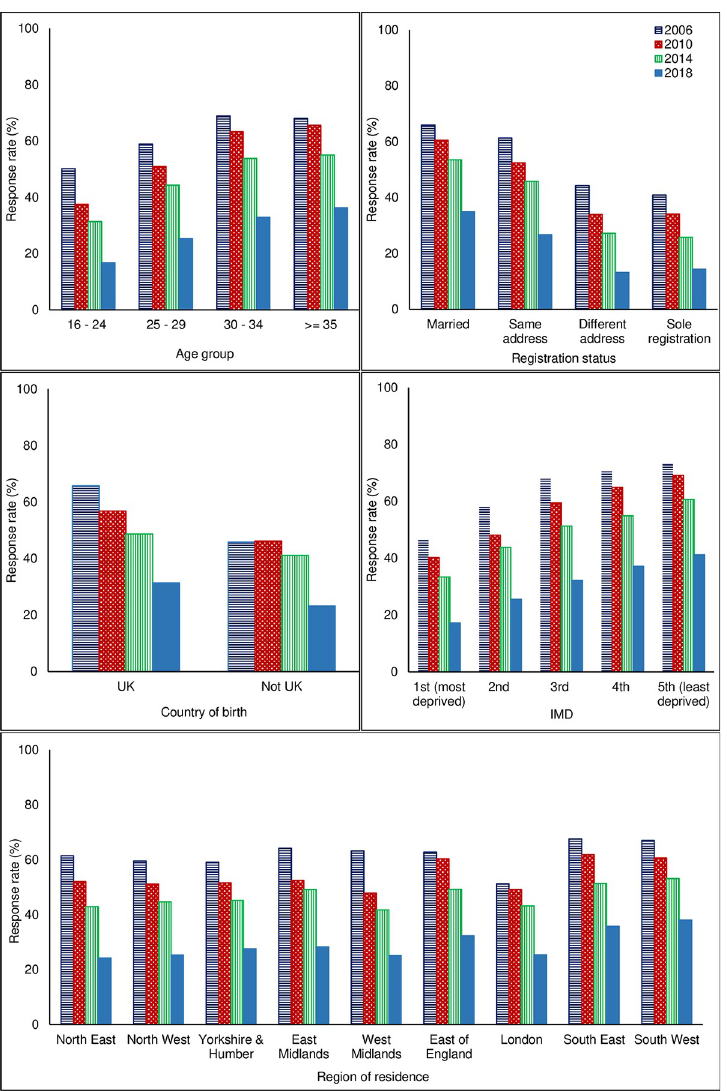
Fig 1. Bar charts to show the association between demographic characteristics and response to the 2006, 2010, 2014 and 2018 national maternity surveys.